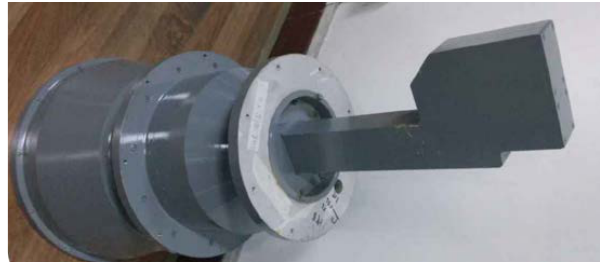
Figure 3. Picture of the antenna.